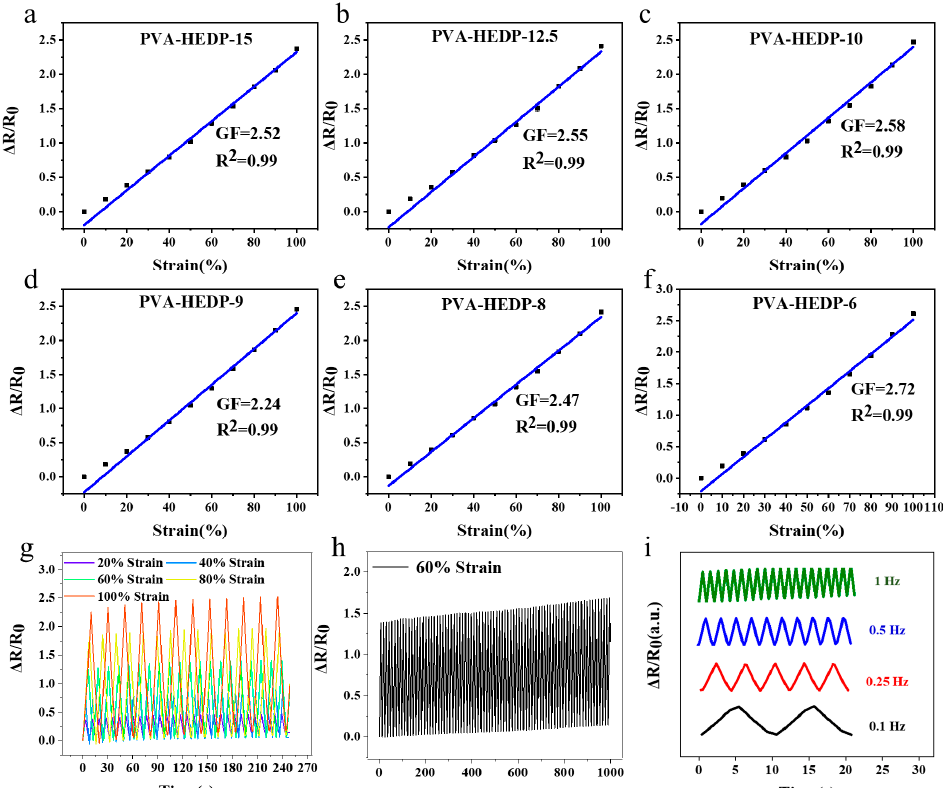
Figure 5. Resistance–strain curves of PVA-HEDP hydrogels with different HEDP content. ( a ) PVA-HEDP-15, ( b ) PVA-HEDP-12.5, ( c ) PVA-HEDP-10, ( d ) PVA-HEDP-9, ( e ) PVA-HEDP-8, ( f ) PVA-HEDP-6. ( g ) Response of the hydrogel to cyclic loading–unloading of 20%–100% strain. ( h ) Response of the hydrogel to cyclic loading–unloading of 60% strain for 1000 s, showing the stability of the strain sensor. ( i ) Frequency response curves of the PVA-HEDP hydrogel-based sensor at applied strain frequencies from 0.1 to 1 Hz under 10% strain.